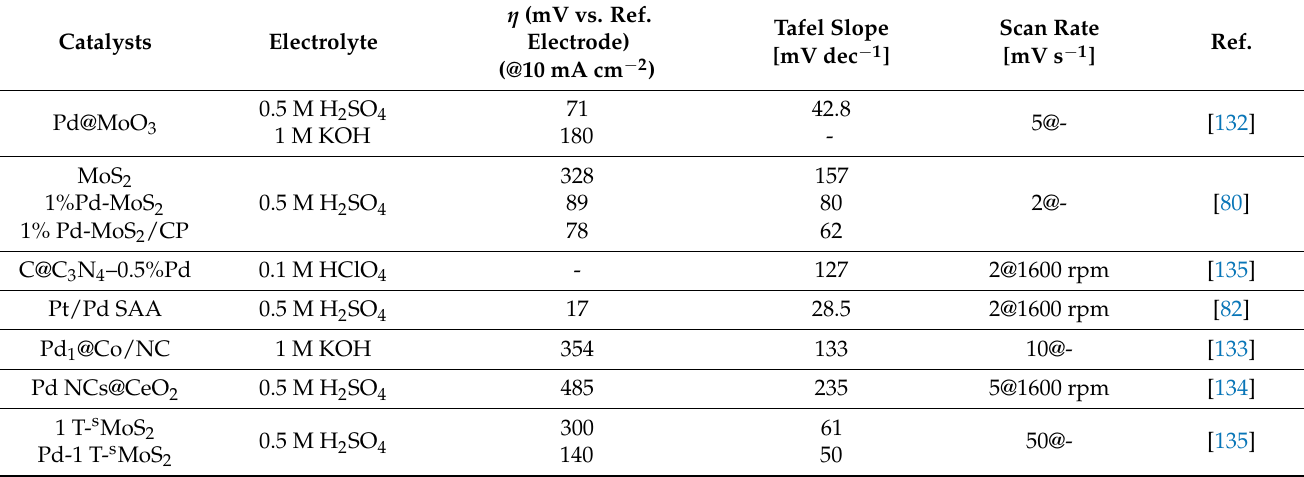
Table 6. Summary of the HER activity of SACs in acidic/alkaline